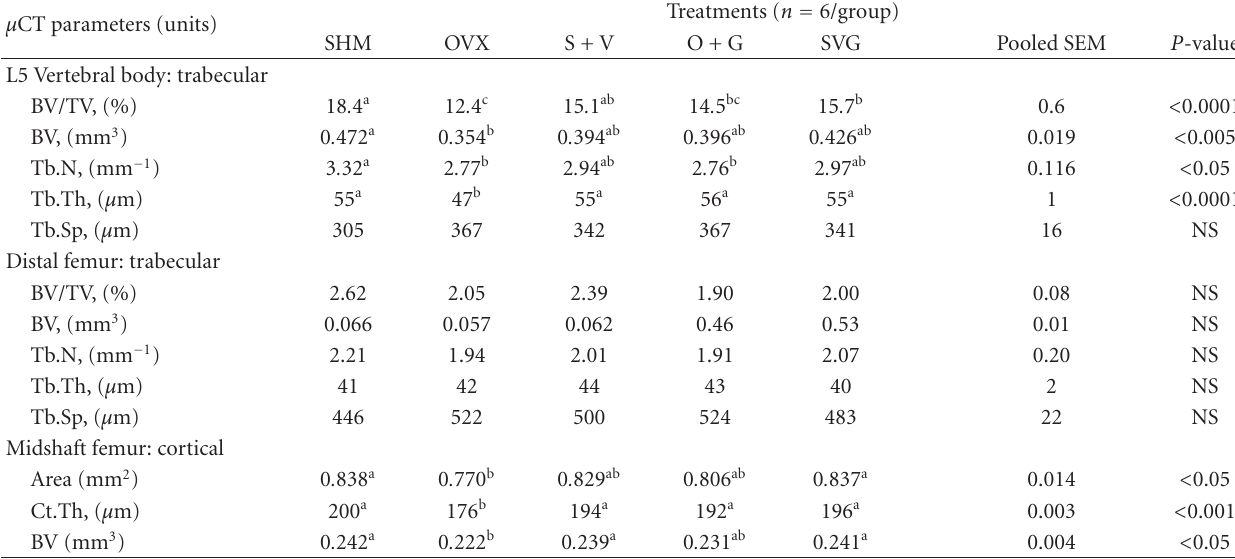
Table 2: Ex vivo microcomputed tomography measures of bone microarchitectural changes in treated mice. μ CT parameters